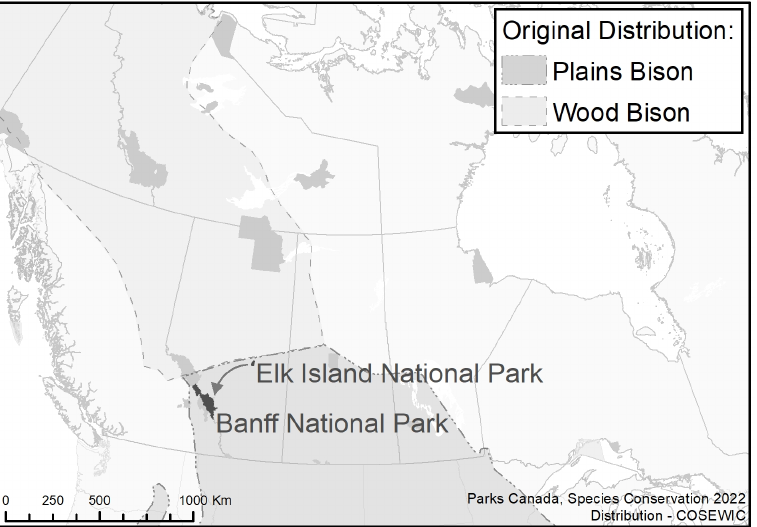
Figure 1. Original range of wood and plains bison in Canada, and the location of Banff NP and its source herd, Elk Island NP .